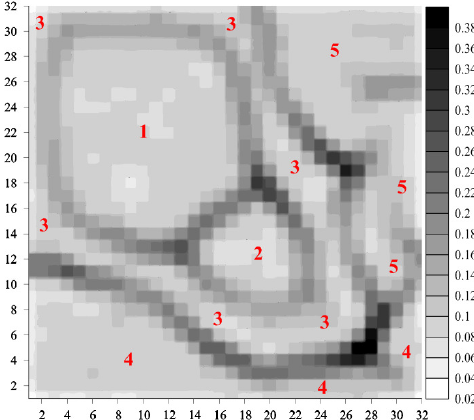
Figure 11. Gray-level U-matrix map for the visualization of the synthetic data set of Figure 6a (U-matrix is calculated for the neuron map of Figure